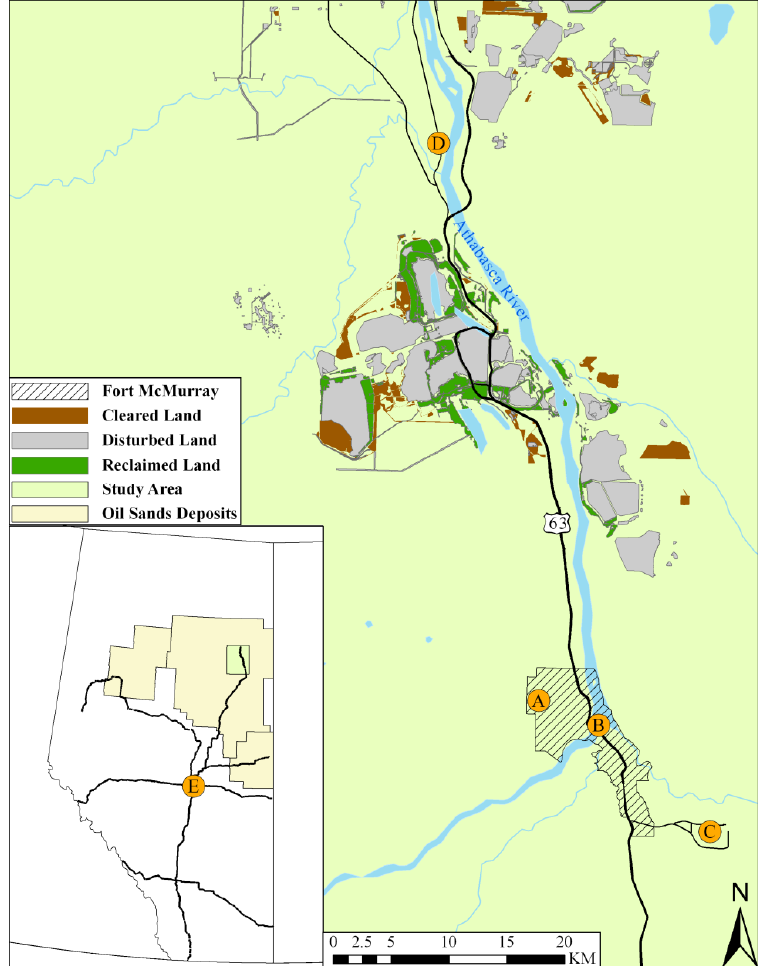
Figure 7. Map of the area showing Patricia McInnes Station (A), Athabasca Valley Station (B), Fort McMurray Airport (C), and Fort McKay (D). Inset map of Alberta shows study area in relationship to Edmonton (E). Fort McMurray and oil sands deposits and production areas are shaded according to the legend